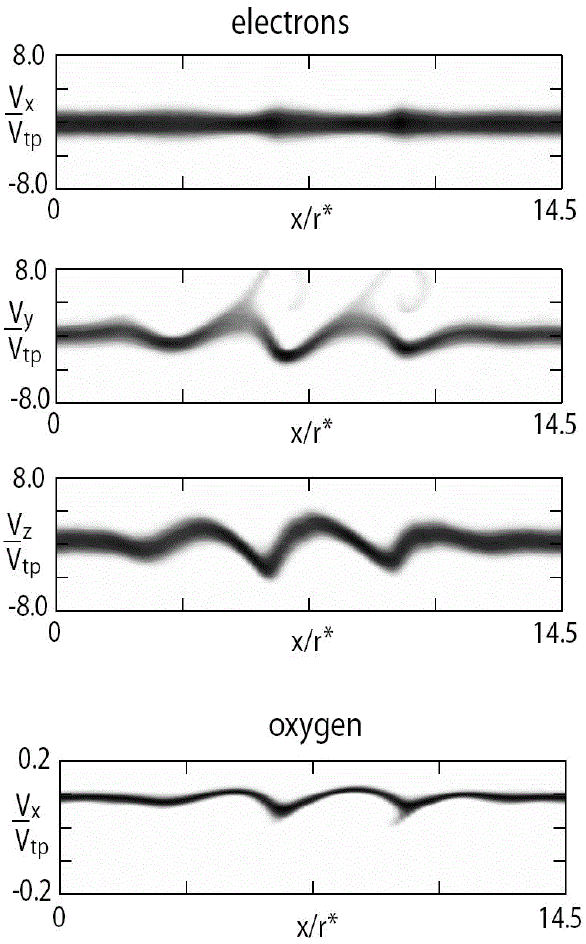
Fig. 6. Electron and ion phase space normalized to the initial proton thermal velocity at the well developed turbulent phase of the PIC